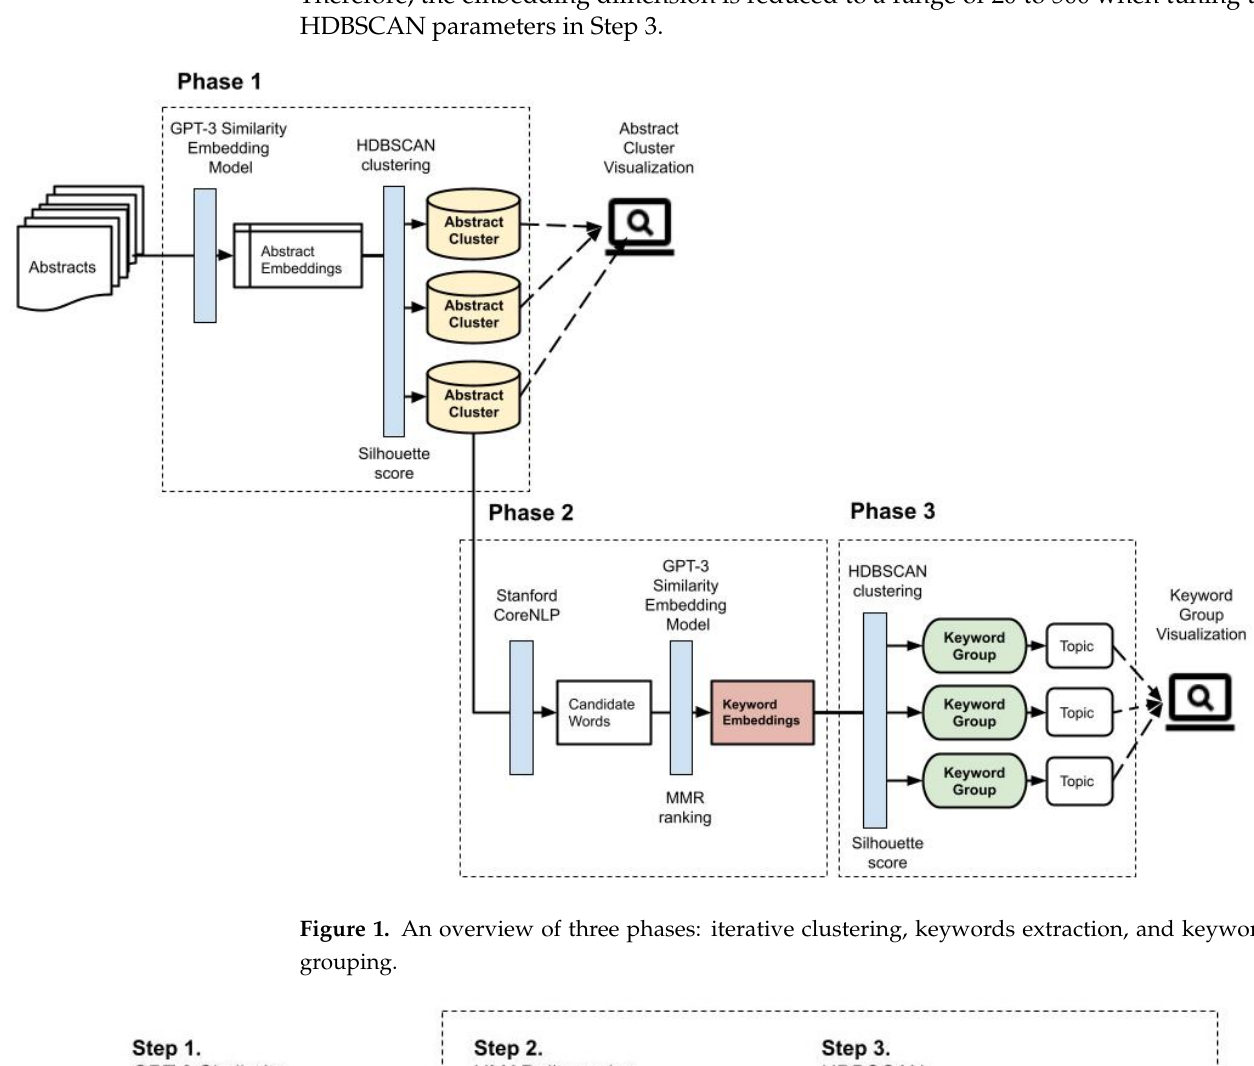
Figure 1. An overview of three phases: iterative clustering, keywords extraction, and keywords grouping.